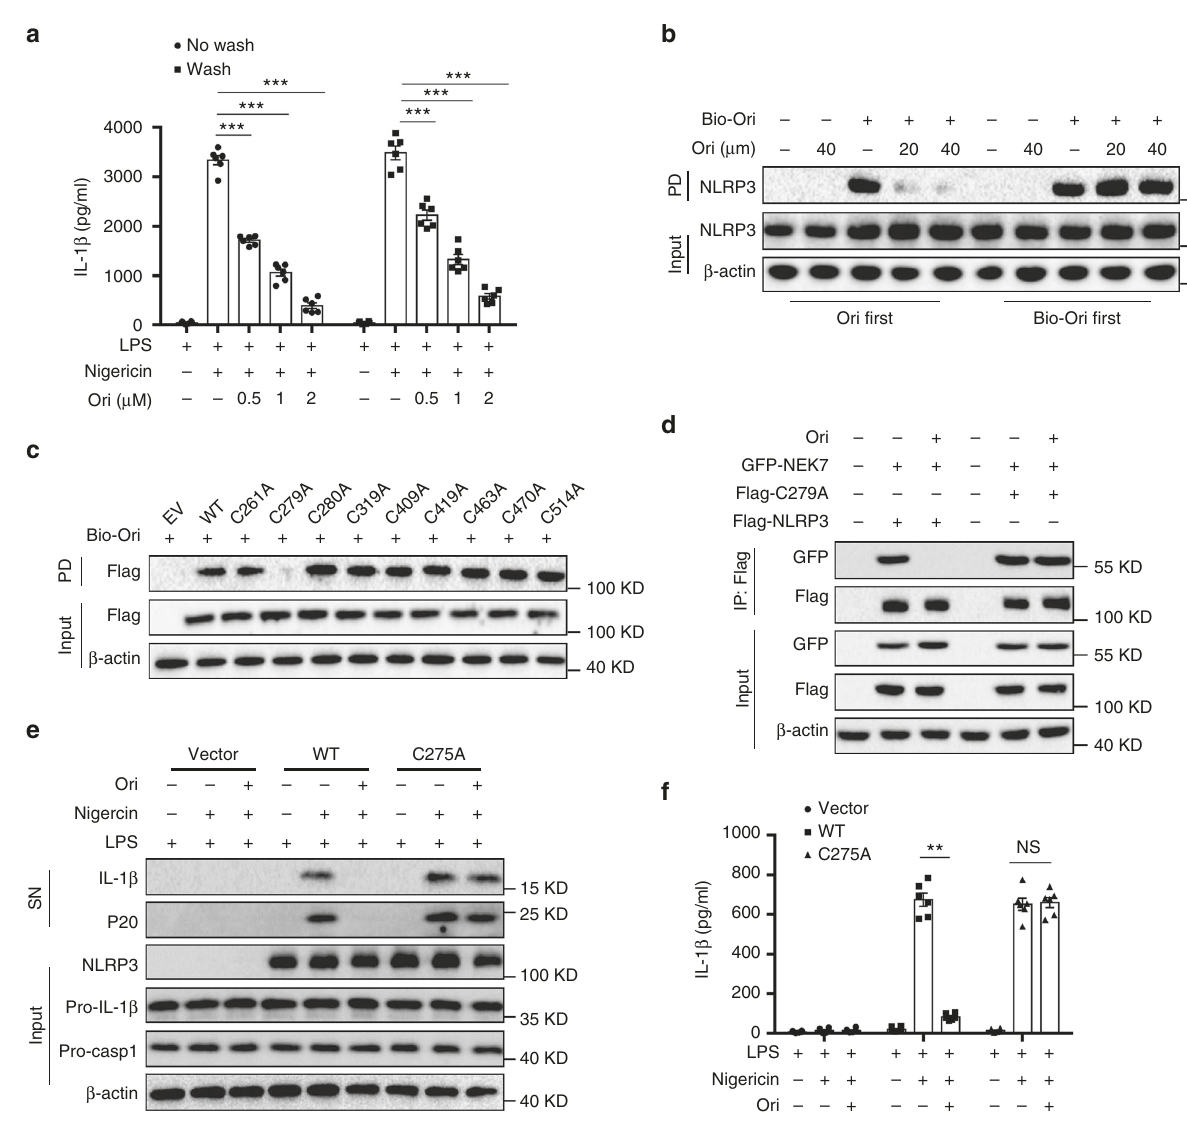
Fig. 4 Ori covalently binds to the cysteine 279 on NLRP3. a ELISA of IL-1 β in SN from LPS-primed BMDMs treated with different doses of Ori for 15 min and washed three times, then stimulated with nigericin. b Cell lysates of LPS-primed BMDMs were incubated with different concentrations of free Ori for 2 h before or after incubated with bio-Ori (1 μ M) for 2 h, and then pulled down using streptavidin beads. c HEK-293T cells were transfected with Flag-tagged WT or indicated mutant NLRP3 constructs. The cell lysates were incubated with bio-Ori (1 μ M) and then were pulled down using streptavidin beads. d IP and western blot analysis of the interaction between NEK7 and WT or mutant NLRP3 in HEK-293T cells. e , f Western blot analysis ( e ) of cleaved IL-1 β and activated caspase-1 or ELISA of IL-1 β ( f ) in SN from LPS-primed Nlrp3 -/- BMDM reconstituted with WT or mutant NLRP3 (C275A) that were pretreated with Ori (2 μ M) for 0.5 h and then stimulated with nigericin. Data are expressed as mean and s.e.m ( n = 6) from three independent experiments ( a , f ) or are representative of three independent experiments ( b – e ). Statistical differences were calculated by unpaired Student ’ s t -test: ** P < 0.01, *** P <